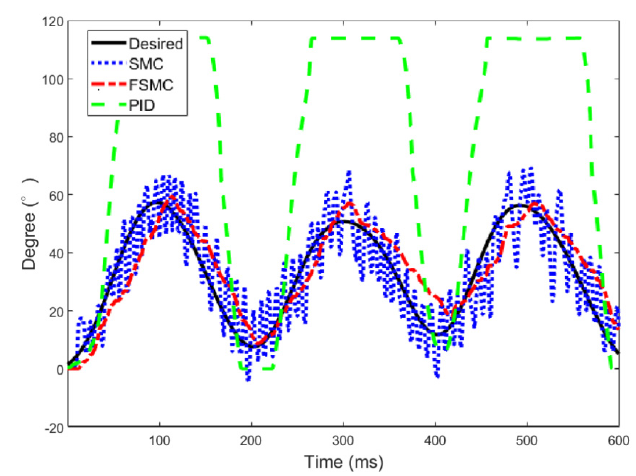
Figure 13. Trajectories of shoulder joint J 4 .